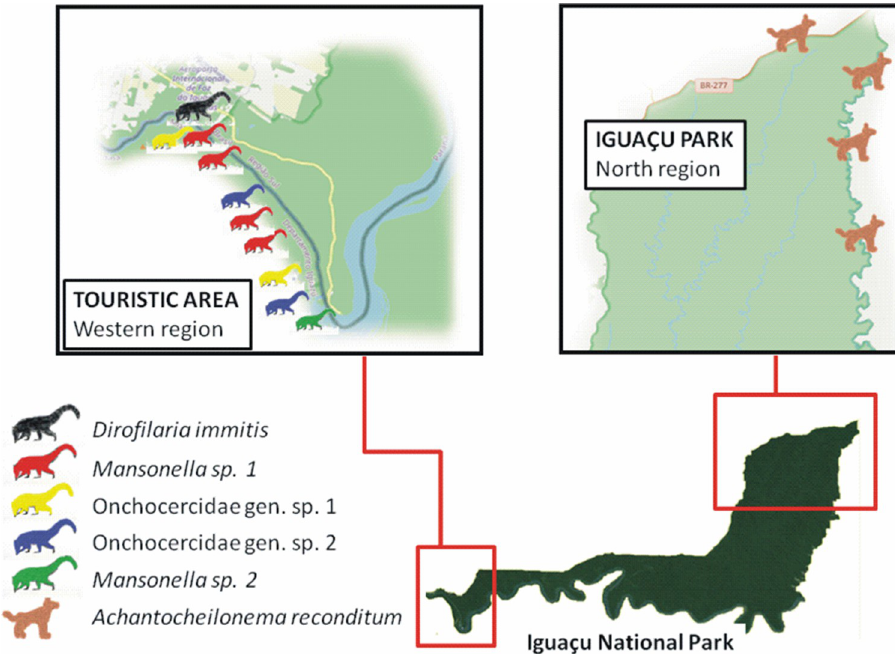
Fig 5. Spatial distribution of the ring-tailed coatis ( Nasua nasua ) and domestic dogs infected by Onchocercidae nematodes, PARNA Iguac¸u. Source of base layer https://www.openstreetmap.org/#map=9/-25.6613/-54.7833.